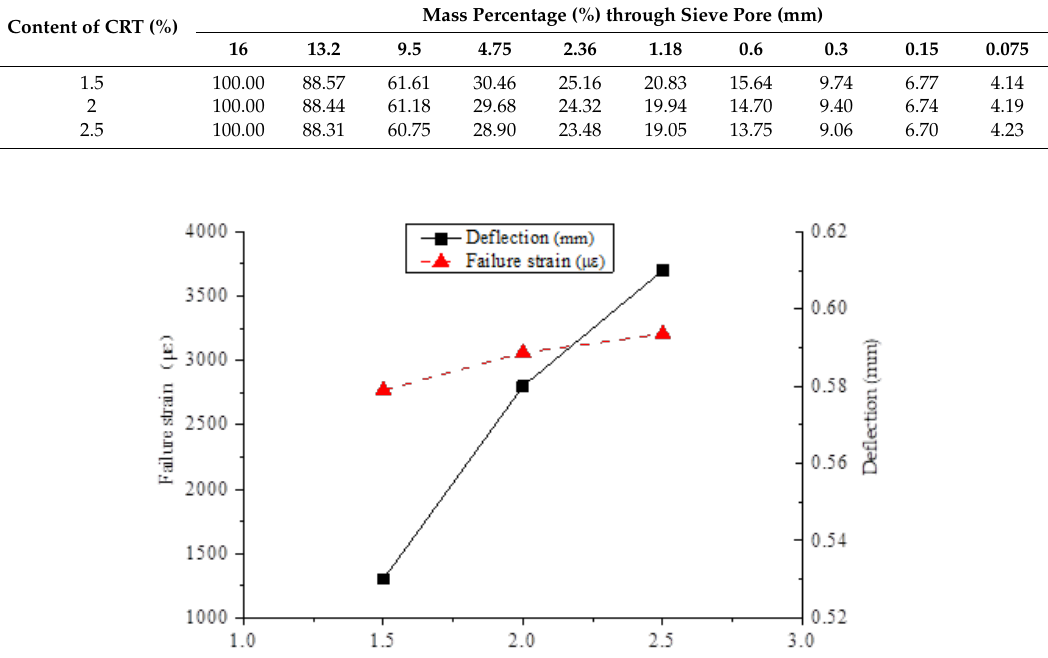
Table 12. Gradation of mixtures under di ff erent CRT contents.